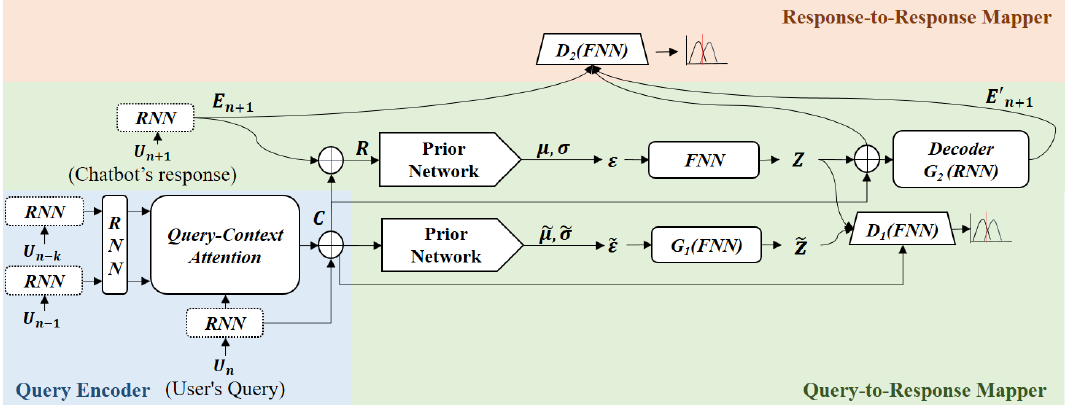
Figure 1. Overall architecture of the proposed chatbot. RNN: recurrent neural network; FNN: fully-connected neural